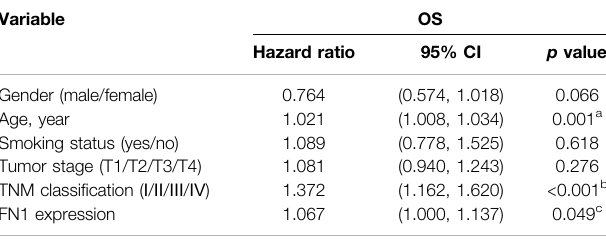
TABLE 2 | Univariate Cox regression analysis of prognostic factors of